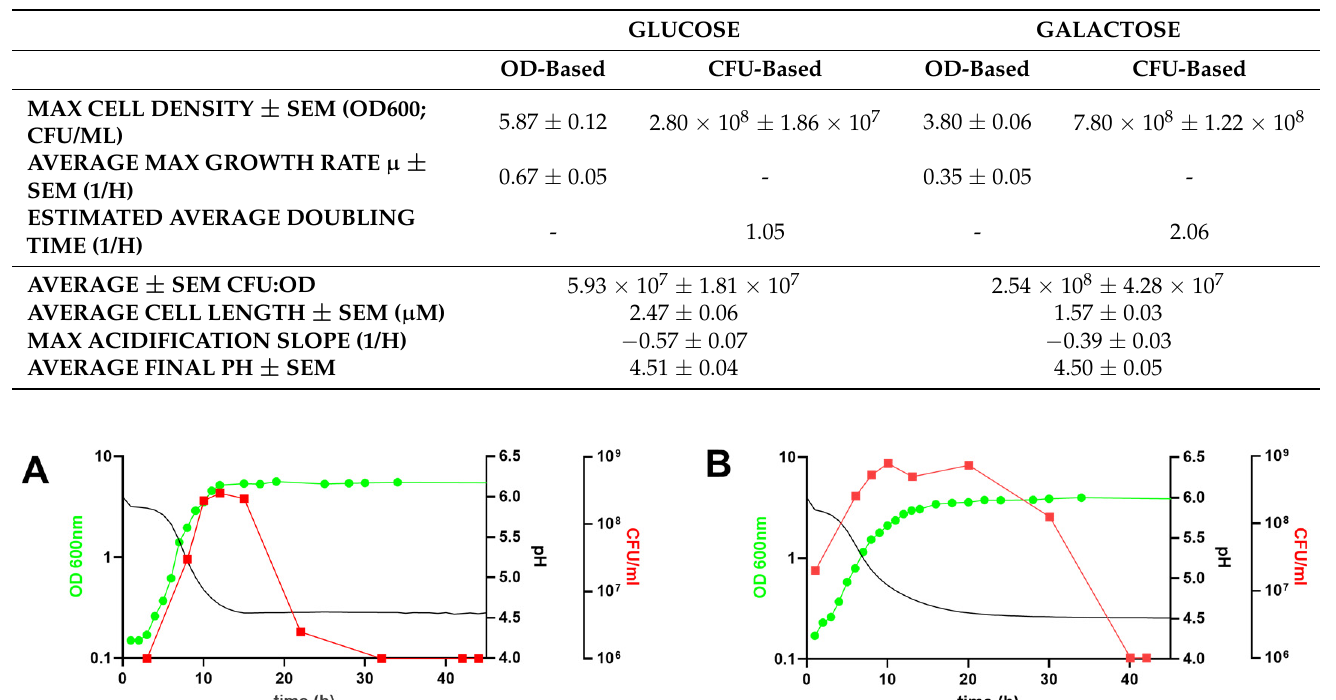
Table 1. Growth characteristics of B. longum NCC 2705 grown in DasGip bioreactors with 1% of glucose or galactose. Maximal acidification slope was obtained by modeling inversed pH values. Maximal growth rate was retrieved from the modelling of the OD curves. An average CFU:OD ratio